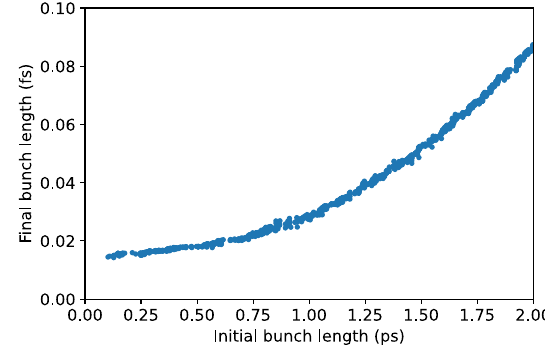
FIG. 2. Dependence of achievable bunch length on initial bunch length at the cathode. An initial transverse spot size of 2 μ m was used for these